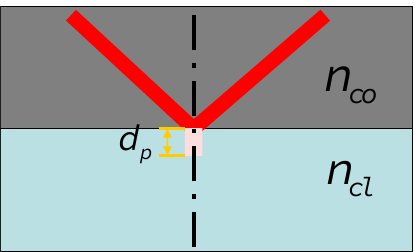
Figure 1. Penetration depth. The evanescent field decays to 1/e of its value at the core-cladding interface.